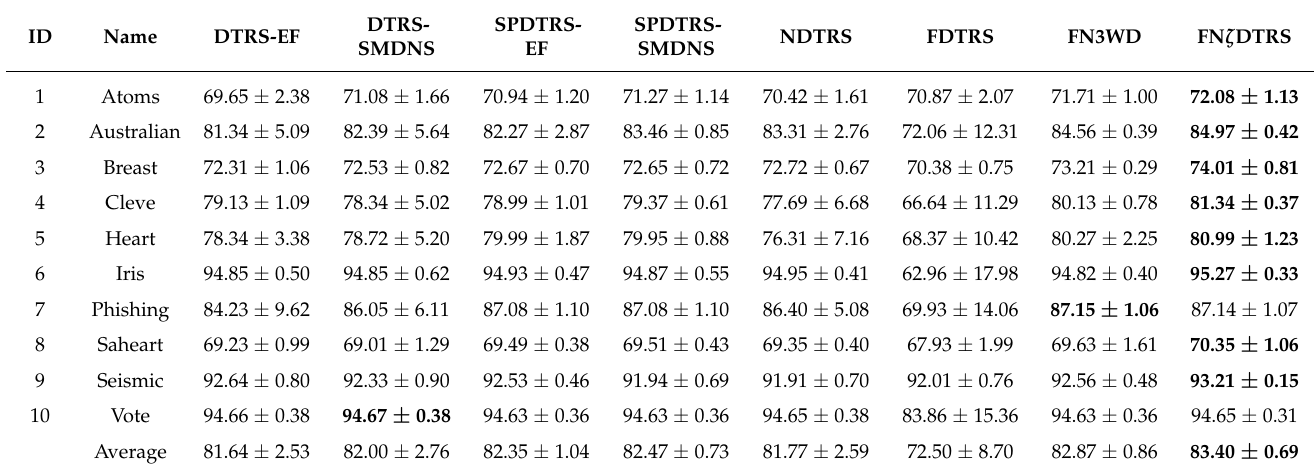
Table 5. The classification accuracy of the reduction subset.